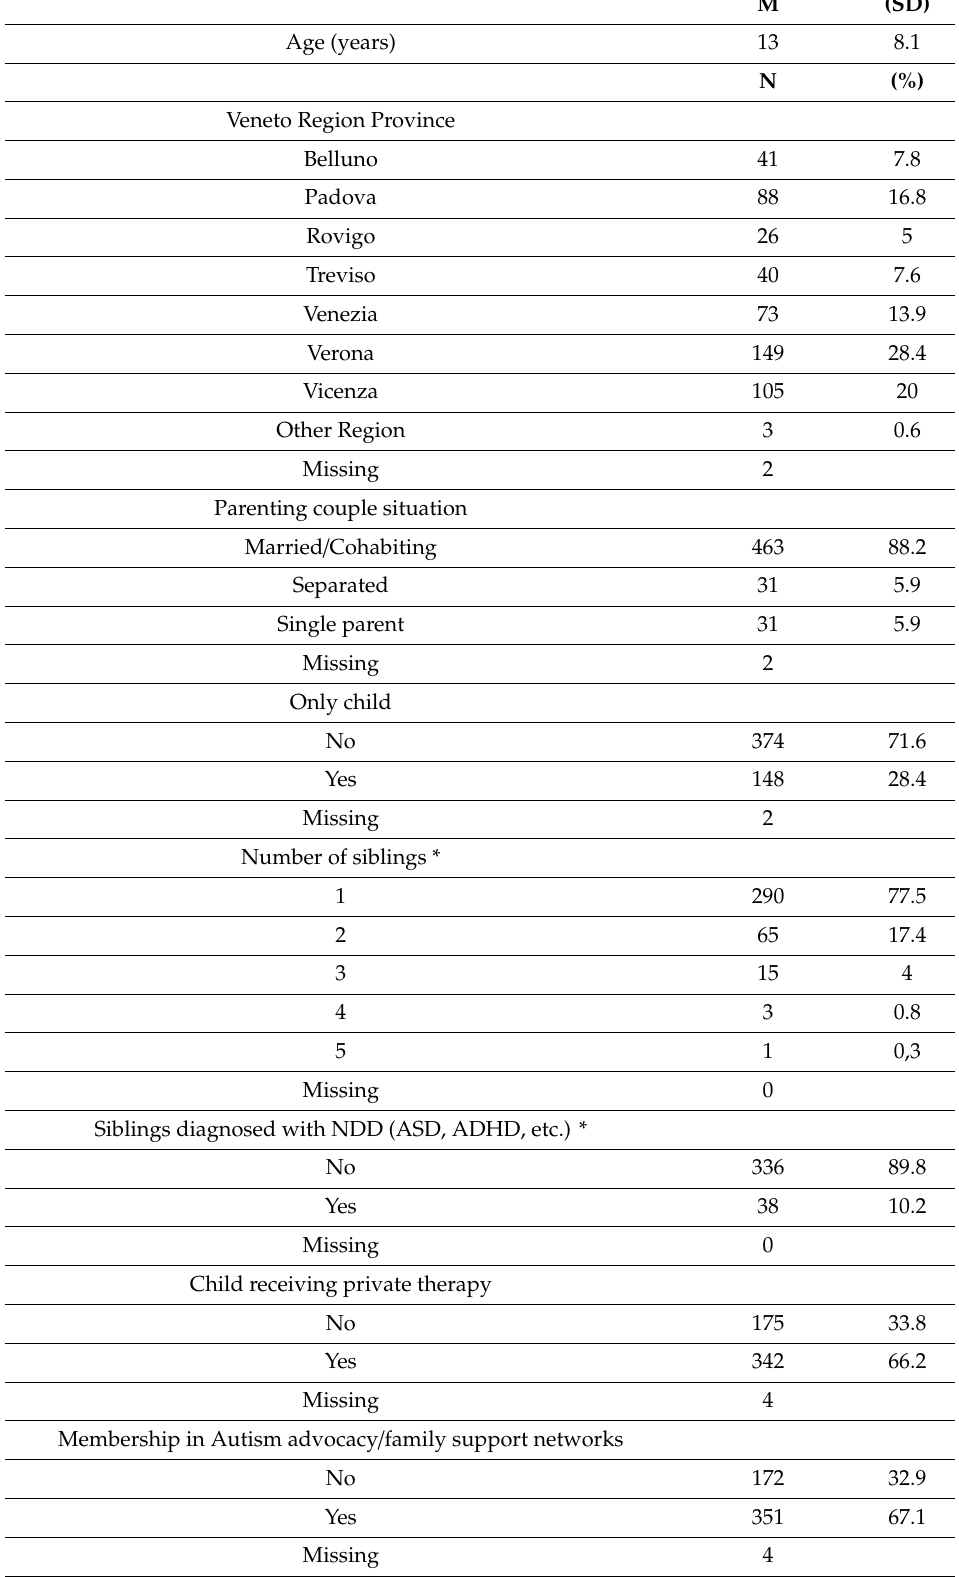
Table 1. Socio-demographic and clinical